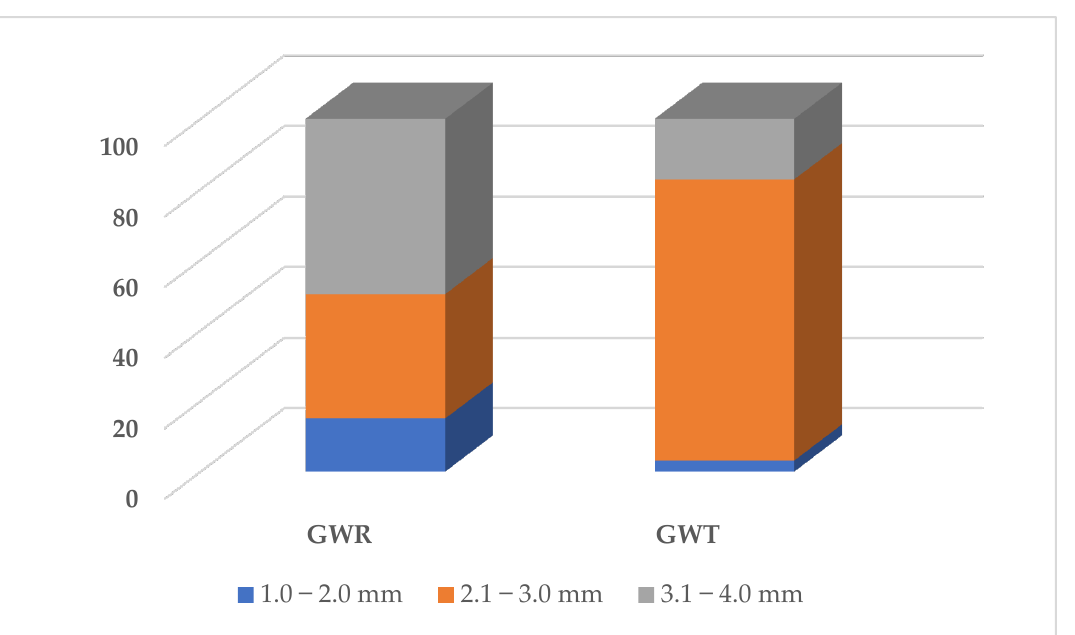
Figure 1. Size distribution of used rubber waste (GWR, GWT) .